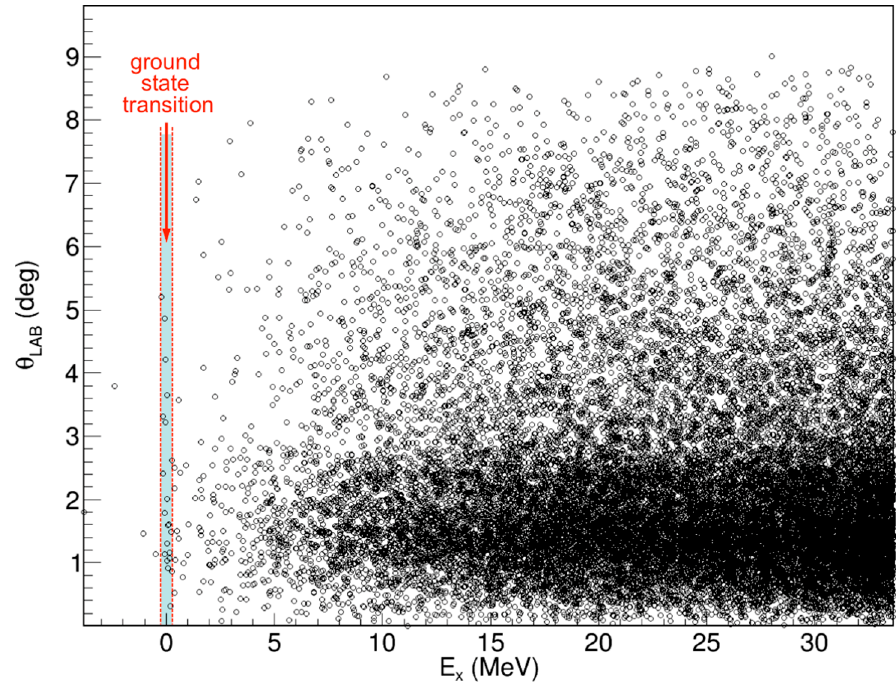
Figure 26. Plot of θ lab versus the excitation energy E x of the final nuclear system in the 76 Se( 18 O, 18 Ne) 76 Ge reaction at 15.3 MeV / amu incident energy. The few events corresponding to the transition toward the 76 Ge ground state are highlighted in the narrow band around E x = 0.